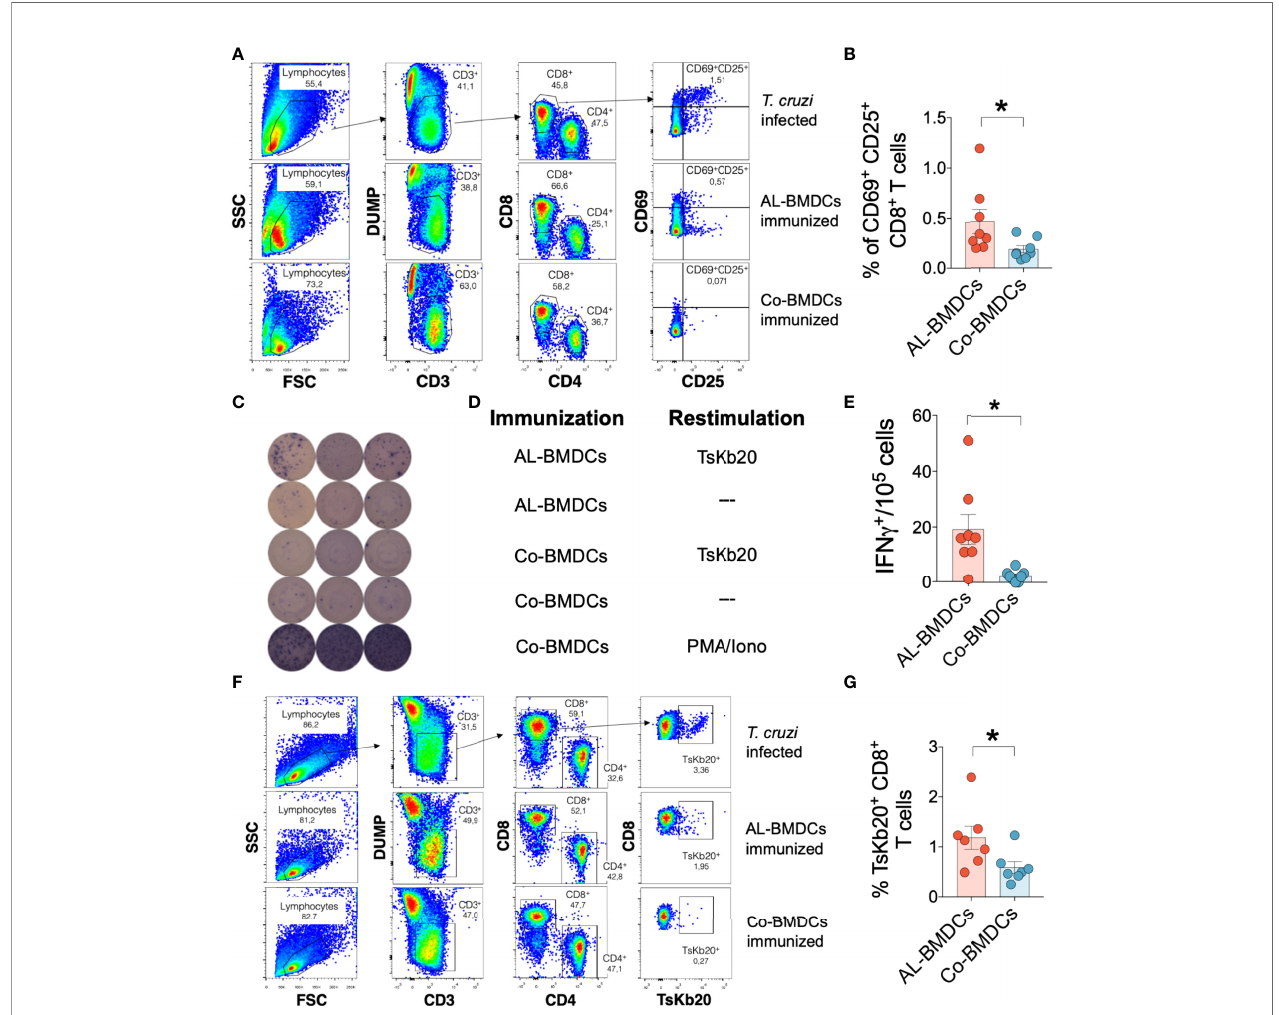
FIGURE 2 | Analysis of the speci fi c CD8 + T cell response in immunized mice. (A) Gating strategy used in AIM assay to determine CD69 + CD25 + CD8 + T cells in lymph nodes from mice infected with T. cruzi (top), immunized with AL-BMDCs (middle) and immunized with Co-BMDCs (bottom). Gating on FSC-H vs . FSC-A plot was used to select singlets (not shown). In the SSC vs . FSC plots, the lymphocyte population was selected, and T cells (CD3 + ) were determined, excluding dead cells, B lymphocytes, and myeloid cells using a DUMP channel. CD4 + and CD8 + T cells were then differentiated. In the latter, the activation percentage was determined by analyzing the CD69 + and CD25 + population. (B) In vitro restimulation of (CD69 + and CD25 + ) CD8 + T cells in the AIM assay for mice immunized with AL-BMDCs or Co-BMDCs, represented as mean + SEM plus dot plots with the value for each mouse (n = 8 per group, Mann-Whitney test, p-value = 0.0159). (C) Representative dot blots of IFN g ELISpot assay for cells derived from lymph nodes. Three representative blots for each condition are shown: lymph node cells from mice immunized with (D) AL-BMDCs and restimulated with TsKb20 peptide ( fi rst row), AL-BMDCs without restimulation (second row), Co-BMDCs restimulated with TsKb20 (third row), Co-BMDCs without restimulation (fourth row) and Co-BMDCs restimulated with PMA/iono ( fi fth row). (E) Number of spots per well (obtained from the difference between restimulated and unstimulated cells) in mice immunized with AL-BMDCs and Co-BMDCs. The mean number of spots ± SEM is represented (n = 8 per group, Mann-Whitney test, p-value = 0.0033). (F) Gating strategy used for the determination of TsKb20 + CD8 + T cells from lymph nodes, doublets were previously excluded (not shown). The TsKb20 + population was determined on CD8 + T cells. (G) Comparison of the percentage of TsKb20 + cells in CD8 + T cells between mice immunized with AL-BMDCs and Co-BMDCs, represented as mean + SEM (n = 8 per group, Mann-Whitney test , p-value =